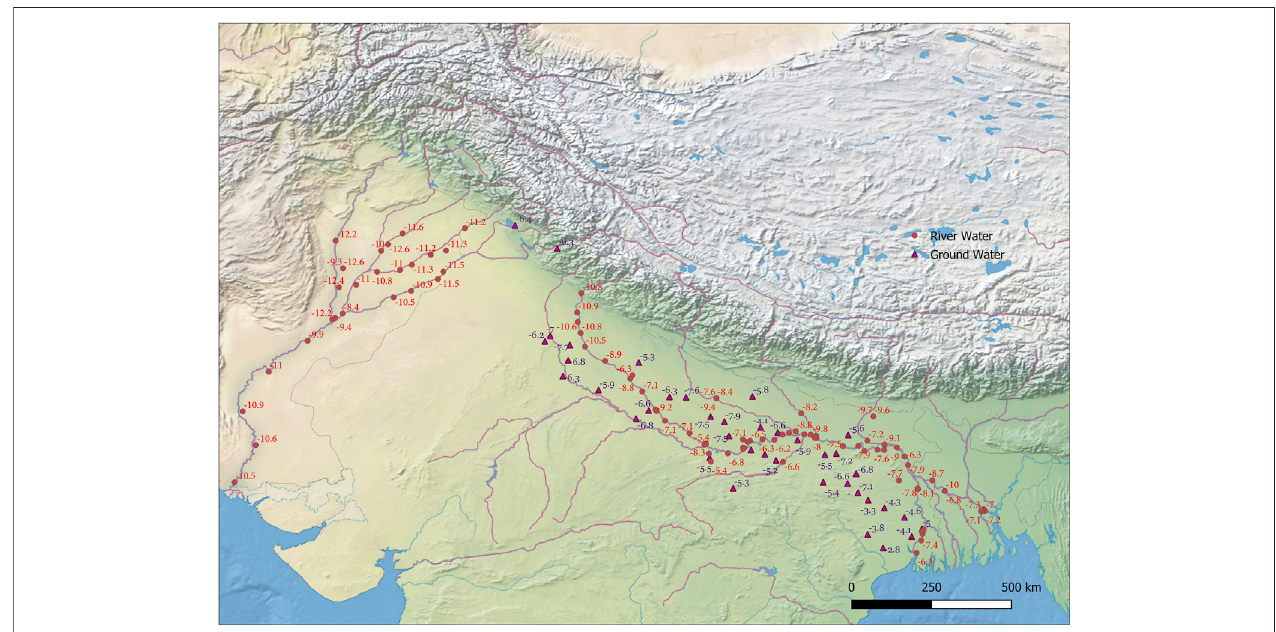
FIGURE 3 | Map showing the spatial distribution of oxygen isotope ratio of Ganga and Indus River system (circles) and oxygen isotope ratios in groundwater (triangles) (Gupta et al., 2005; Karim, 2002).